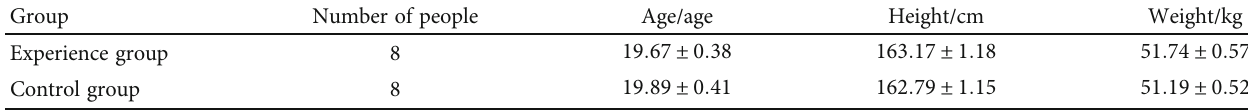
Table 1: Basic information of experimental group and control group.